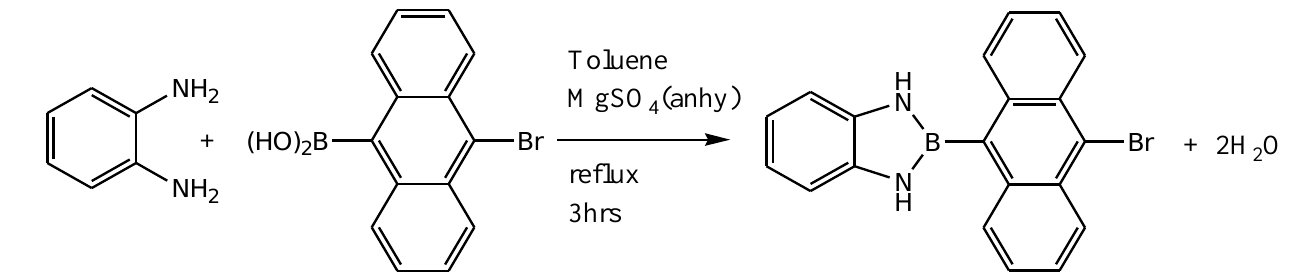
Figure S1: 1 HNMR spectrum of 2-{9-(10-Bromoanthracenyl)}-1,3-dihydro-1 H -[ d ]-1,3,2-benzodiazaborole; Figure S2: 13 C NMR of 2-{9-(10-Bromoanthracenyl)}-1,3-dihydro-1 H -[ d ]-1,3,2-benzodiazaborole; Figure S3: FT-IR of 2-{9-(10-Bromoanthracenyl)}-1,3-dihydro-1 H -[ d ]-1,3,2-benzodiazaborole; Figure